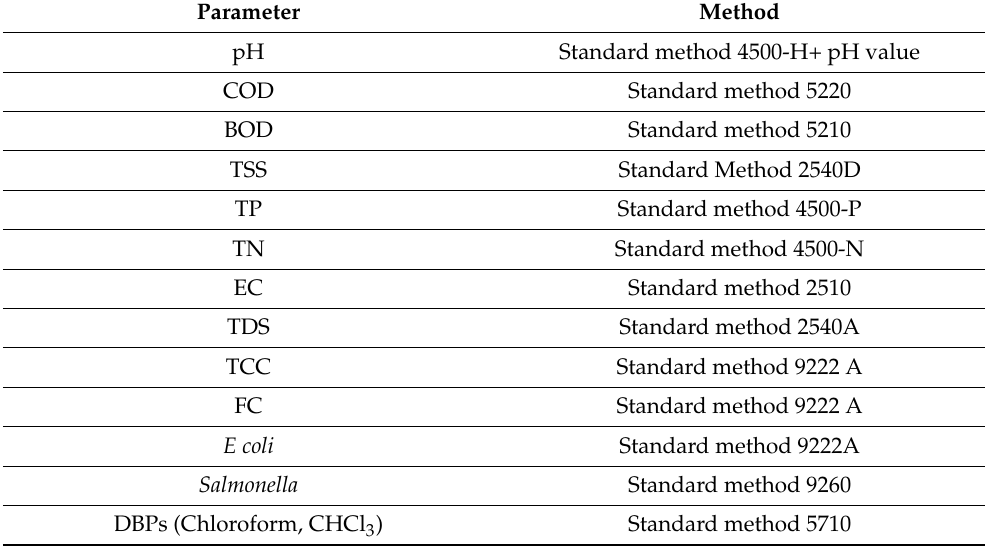
Table 2. Analytical